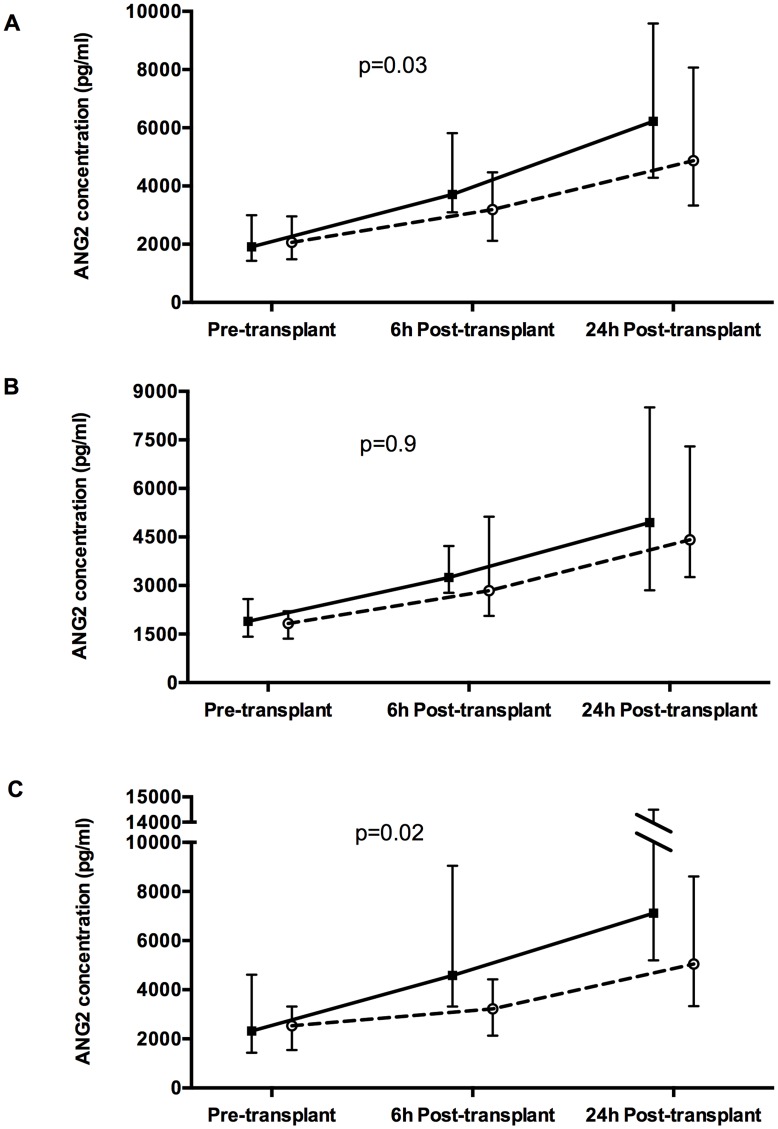
Longitudinal median Angiopoietin 2 level across the pre-transplant, 6-h post-transplant, and 24-h post-transplant time points.A) all study subjects, B) subjects with COPD, and C) subjects with IPF. Solid line represents PGD cases and dashed line represents PGD-free controls. Error bars represent the 95% CI. All p-values reported are from GEE modeling.